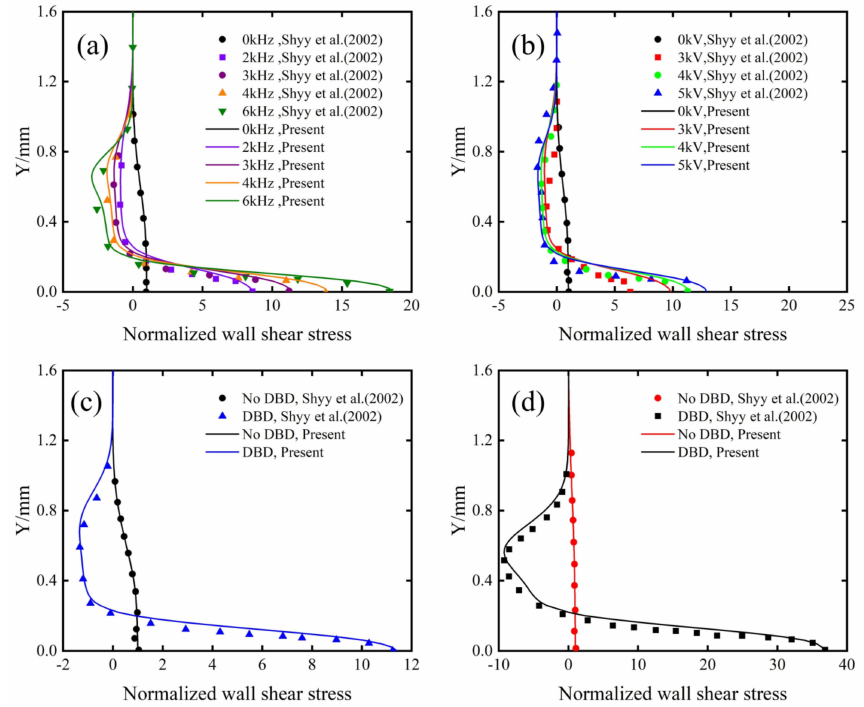
Figure 5. Effects of different parameters on wall shear stress at ST4. ( a ) Frequency, ( b ) voltage, ( c ) inlet velocity with 5 m/s, ( d ) inlet velocity with 2